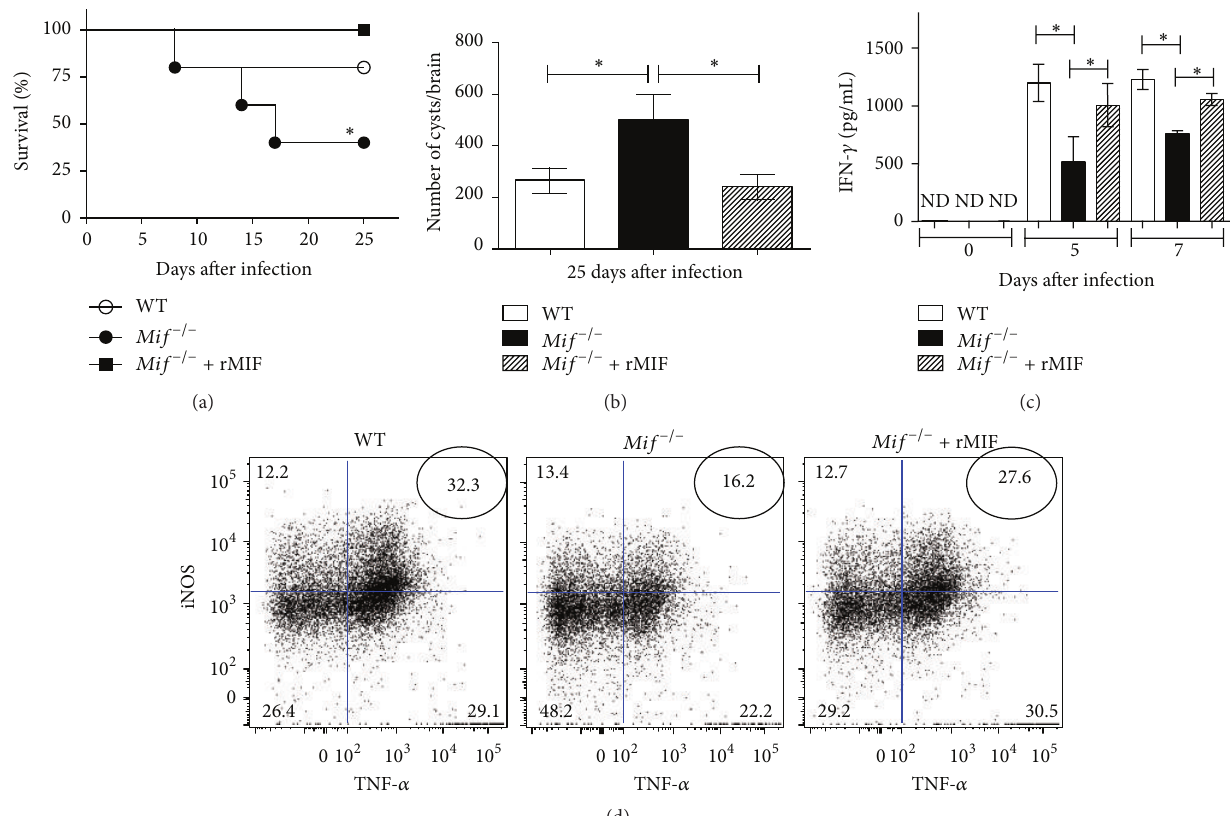
Figure9:AdministrationofrMIFrestoresTipDCsandresistanceto T.gondii infectionin Mif −/− mice. T.gondii -infected Mif −/− micereceived 0.5 𝜇 g of rMIF over the first 5 days of infection and were compared to infected WT and Mif −/− mice treated with PBS. (a) Survival rate of T. gondii -infected mice. (b) Number of cysts in brain from infected mice at 25 days after infection. (c) Serum IFN- 𝛾 levels from infected mice at 0, 5, and 7 days after infection. (d) Representative dot plots of TipDCs in the site of infection ( 𝑛 = 3 animals/group, representative of 2 independent experiments). Significant differences were calculated with the log rank test and Student’s 𝑡 -test. ND: not detected. Data are presented as the mean ± SE. ∗ 𝑃 < 0.05